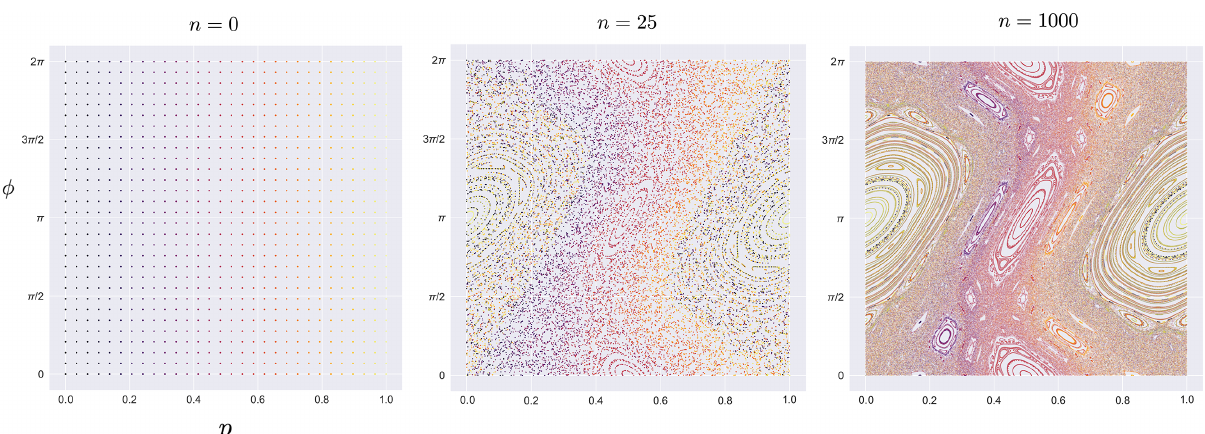
( j ) ) = ( j / 30, 2 π k / 30 ) , with j , k = , φ ( k ) 0 0